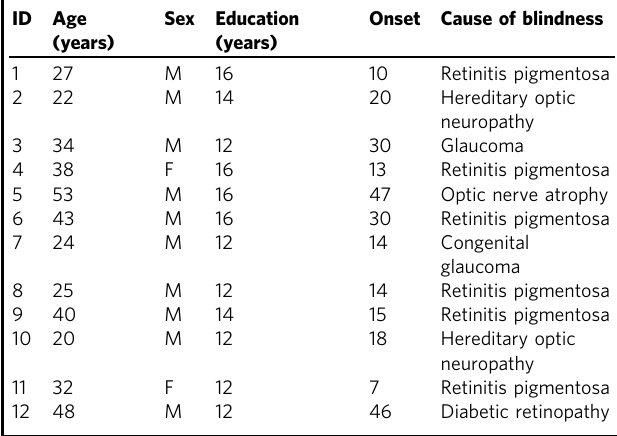
Table 1 Demographics of the blind